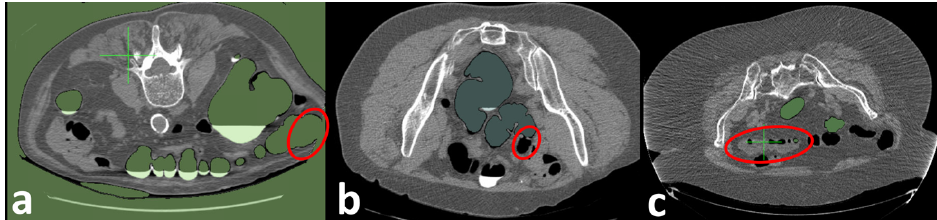
Figure 9. Examples of bad scans that need manual annotations: ( a ) Patient is not accurately positioned, ( b ) thickened colonic folds, and imaging artifacts and distortion due to low-dose CT.,( c ) patient is not good prepped (colon is not